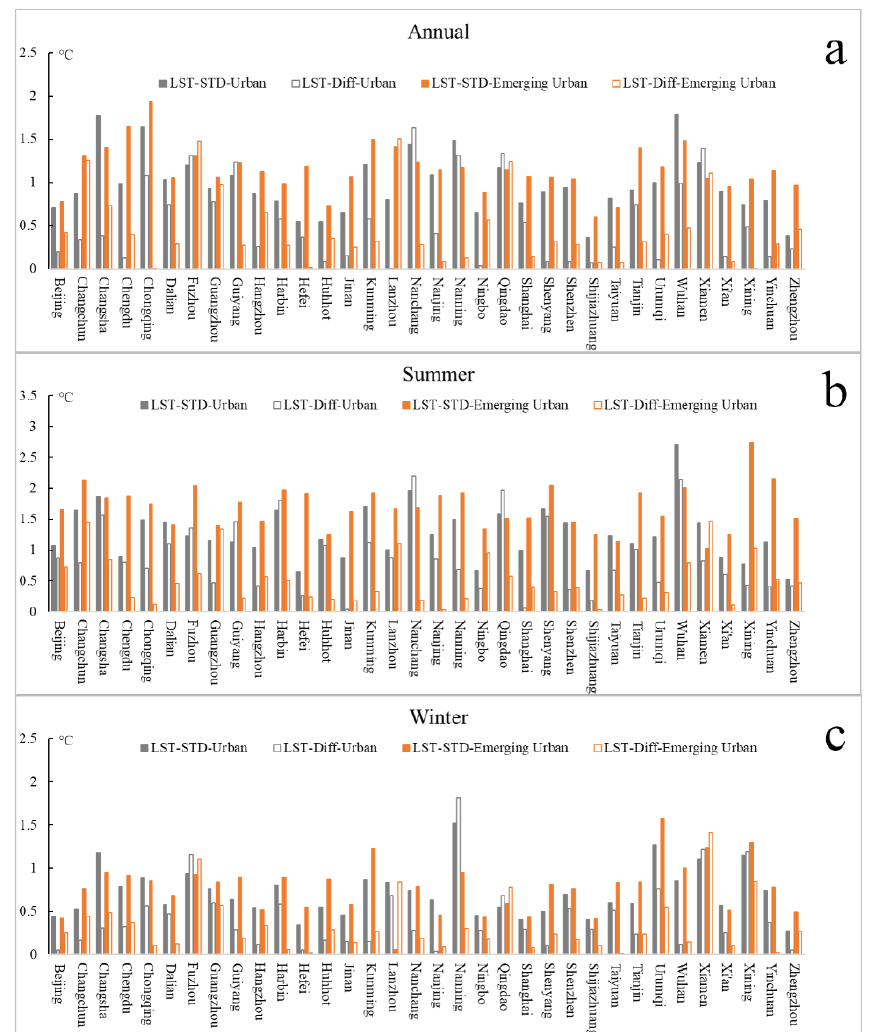
Figure 10. LST-STDs and LST-Diffs of the 34 cities: ( a ) annual, ( b ) summertime, and ( c ) wintertime. LST-STD is defined as the standard deviation of LST for the whole urban area or emerging urban areas shown in Figure 1. LST-Diff is defined as the absolute value of the difference between the average LST of the selected urban window (or emerging urban windows) and the average LST of the whole urban areas (or emerging urban